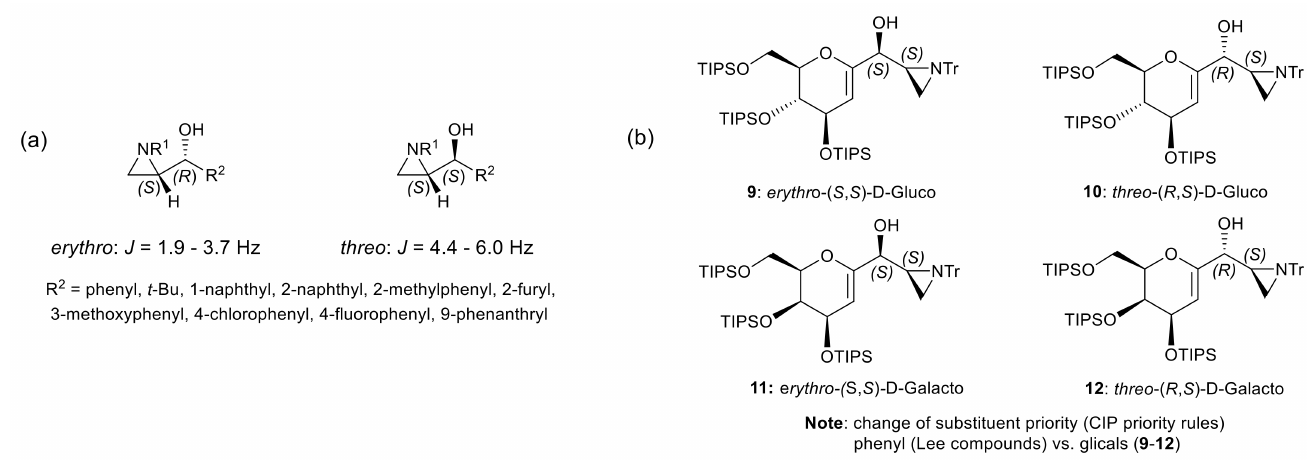
Figure 2. ( a ) Coupling constants of erythro and threo isomers according to literature data [83–86]; ( b ) configuration of erythro and threo obtained isomers 9 – 12